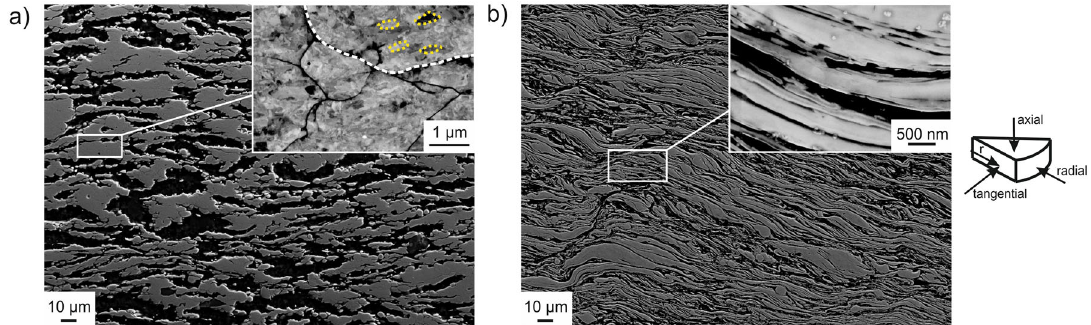
Fig. 1 Microstructure of the two types of Mg – Fe composites. SEM images in BSE contrast acquired in radial direction of the disk-shaped samples. a Coarse Mg – Fe processed by CHPT. The dashed white line outlines an Fe particle with subgrains developed within (marked by dotted yellow lines); b Nanostructured Mg – Fe processed by monotonic